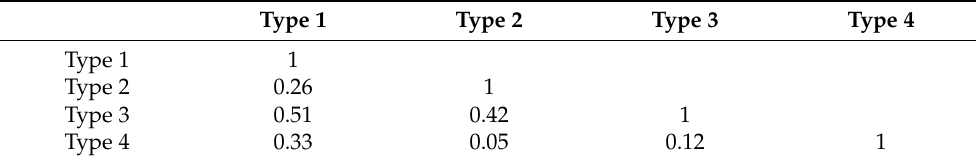
Table 4. Correlations between types.